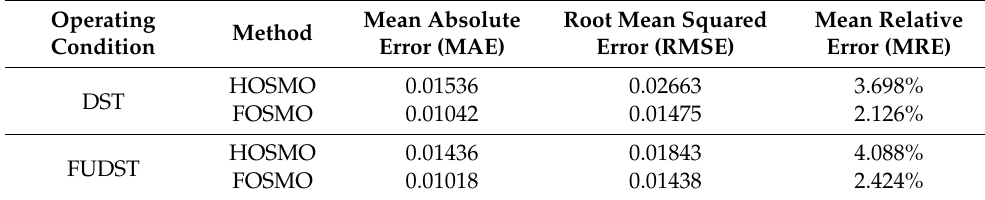
Figure 7. True value of the SoC and the estimated SoC under FOSMO and HOSMO from FUDST. By analyzing the data in Figures 5 and 7, the estimation value of the SoC under DST and FUDST conditions are conducted with the mean absolute error (MAE), root mean squared err (RMSE), and mean relative error (MRE), as shown in Table 2. We can conclude that the real-time estimation error fluctuation in FOSMO is smaller than the HOSMO-based method, especially the RMSE and MRE, with better performance. Table 2. The SoC estimation under the DST and FUDST